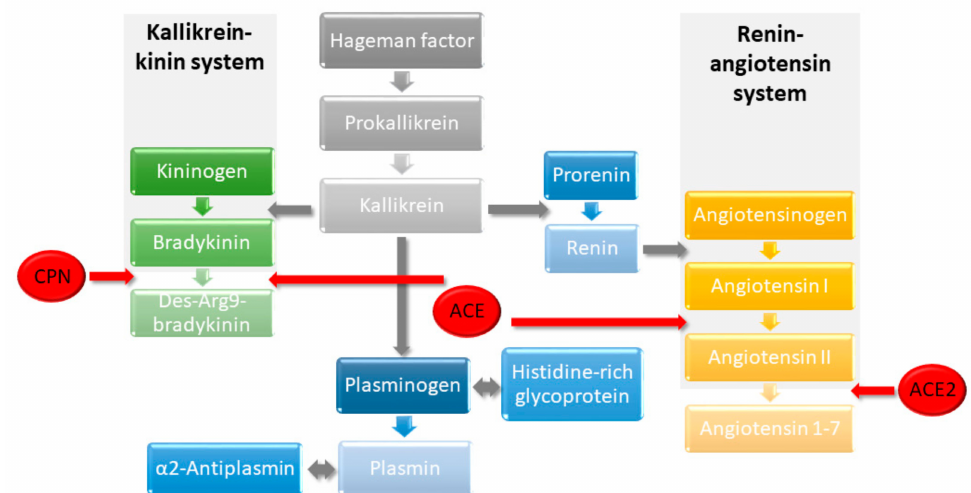
Figure 7. Schematic of the extended RAS and KKS networks, which are connected by ACE. Vasoactive bradykinin is formed from kininogen (KNG1), assisted by kallikrein (KLKB1) and degraded by CPN. KLKB1, which needs Hageman factor (complement factor 12, F12) to be formed from its precursor, also influences the RAS by catalyzing the cleavage of prorenin to renin, which in turn is needed for the formation of angiotensin I from angiotensinogen (AGT). The subsequent formation of angiotensin II by ACE ensures blood pressure homeostasis and is counterbalanced by ACE2, which cleaves angiotensin II. KLKB1 can furthermore activate F12 and plasminogen (PLG). Plasmin degrades fibrin, initiating fibrinolysis, and is inhibited by α 2-antiplasmin (SERPINF2). Histidine-rich glycoprotein (HRG) binds PLG and